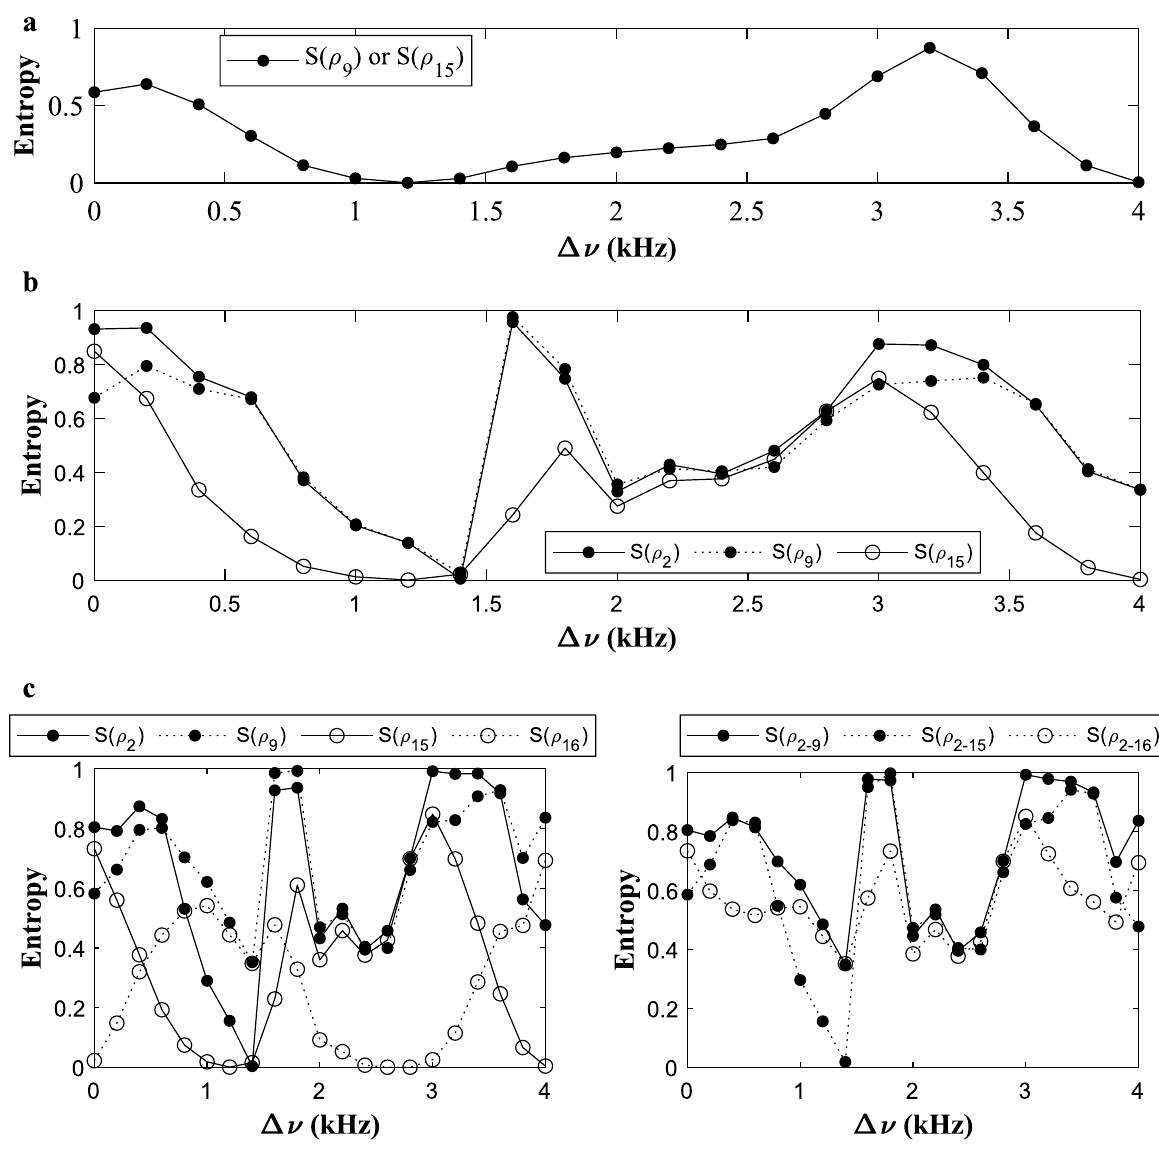
Figure 3. N = 2,3, 4 entropy of entanglement. Variations in the entropy of entanglement S ( ρ ) values of the partially traced states. The entropy is normalized to log2 . ( a ) S (ρ 9 ) or S (ρ 15 ) of two logical phi-bits (9, 15). ( b ) S (ρ 2 ) , S (ρ 9 ) , S (ρ 15 ) of the three phi-bits (2, 9, 15). ( c ) Entropy of entanglement of the four phi-bits (2, 9, 15, 16) by taking the partial trace over one phi-bit i.e., S (ρ 2 ) , S (ρ 9 ) , S (ρ 15 ) , S (ρ 16 ) (left panel) or over two phi-bits i.e. S (right